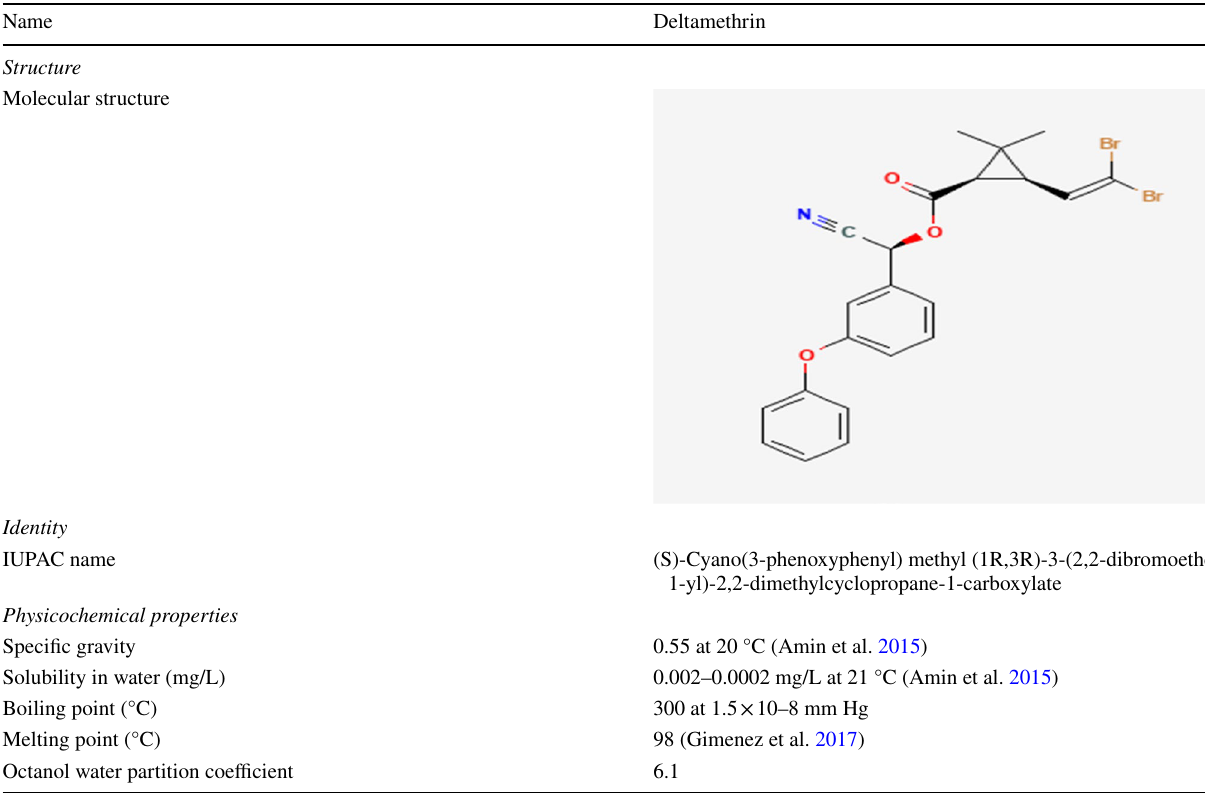
Table 1 Properties of deltamethrin